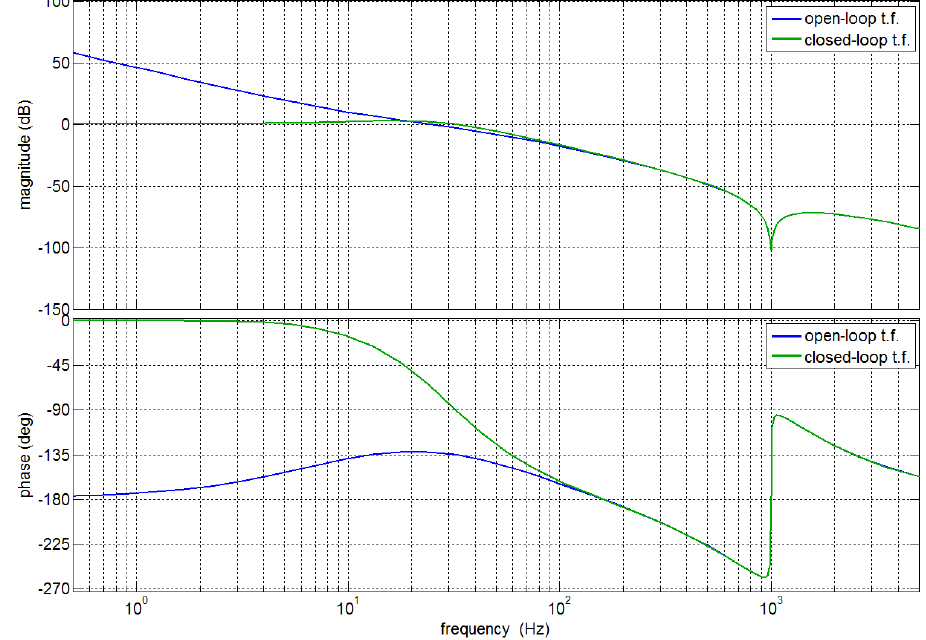
Figure 4. Bode diagram of the open-loop and closed-loop transfer functions representing the dynamics of the Phase-Locked Loop (PLL) schematic in Figure 2.